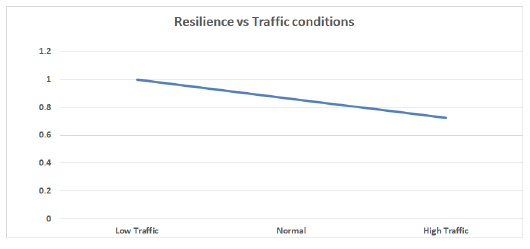
Figure 13. Resilience vs. different traffic